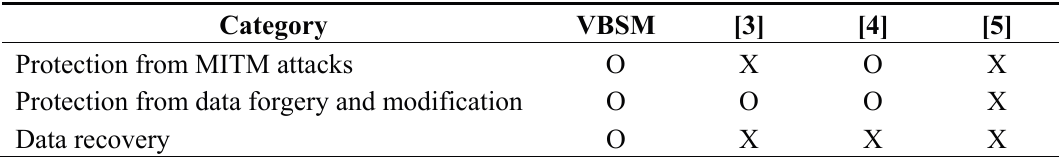
Table 2. Analyses of